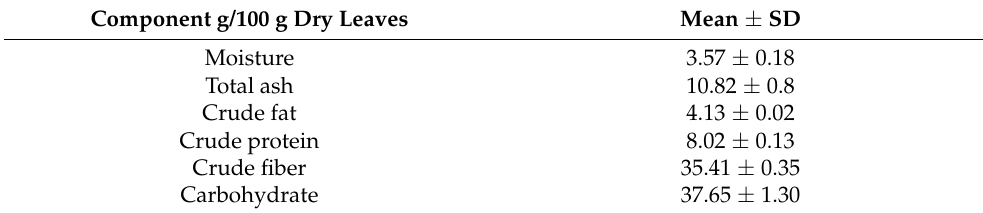
Table 1. Proximate composition (mean ± SD) of dried/ground olive leaves. Component g/100 g Dry